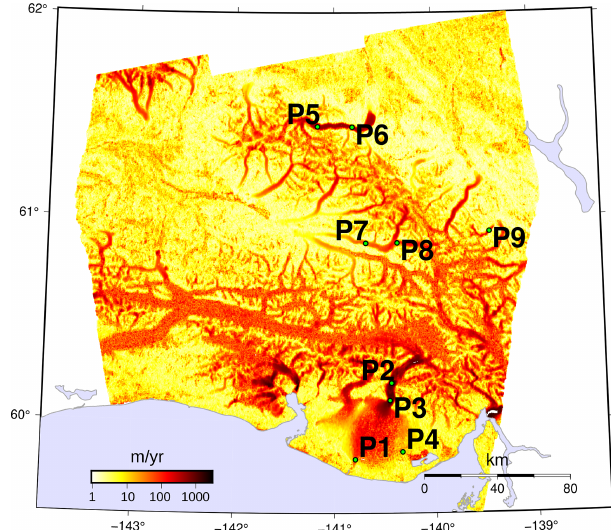
Figure 6. Magnitude of mean 3D flow velocities plotted using loga- rithmic scale. For regions P1–P4 at Malaspina and Seward glaciers, P5–P6 at Klutlan Glacier, P7–P8 at Walsh Glacier, and P9 at Kluane Glacier time series are provided in Figs. 11 and